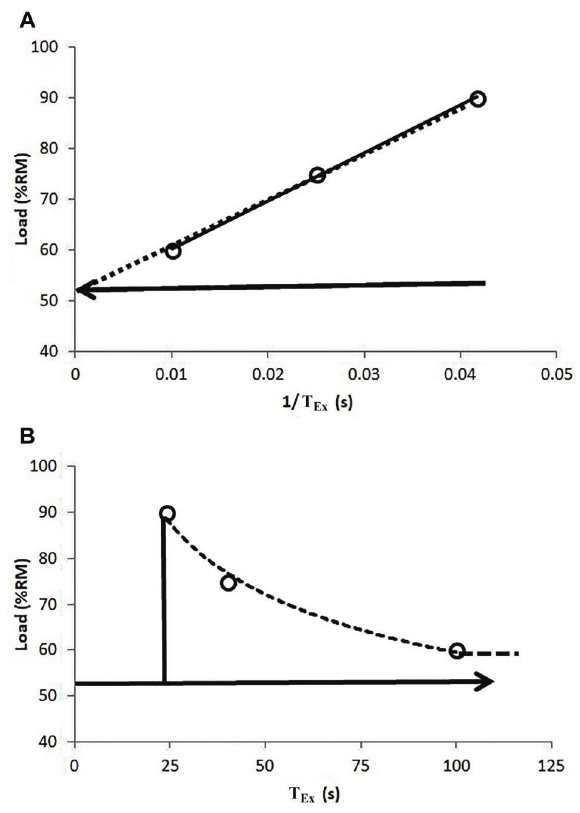
Figure 2. The load-time relationship in response to three pro- gressive resistance exercise tests for all subjects. A , Linearized response as a function of percentage peak load. B , A hyperbolic relationship was found in all subjects. The asymptote represents